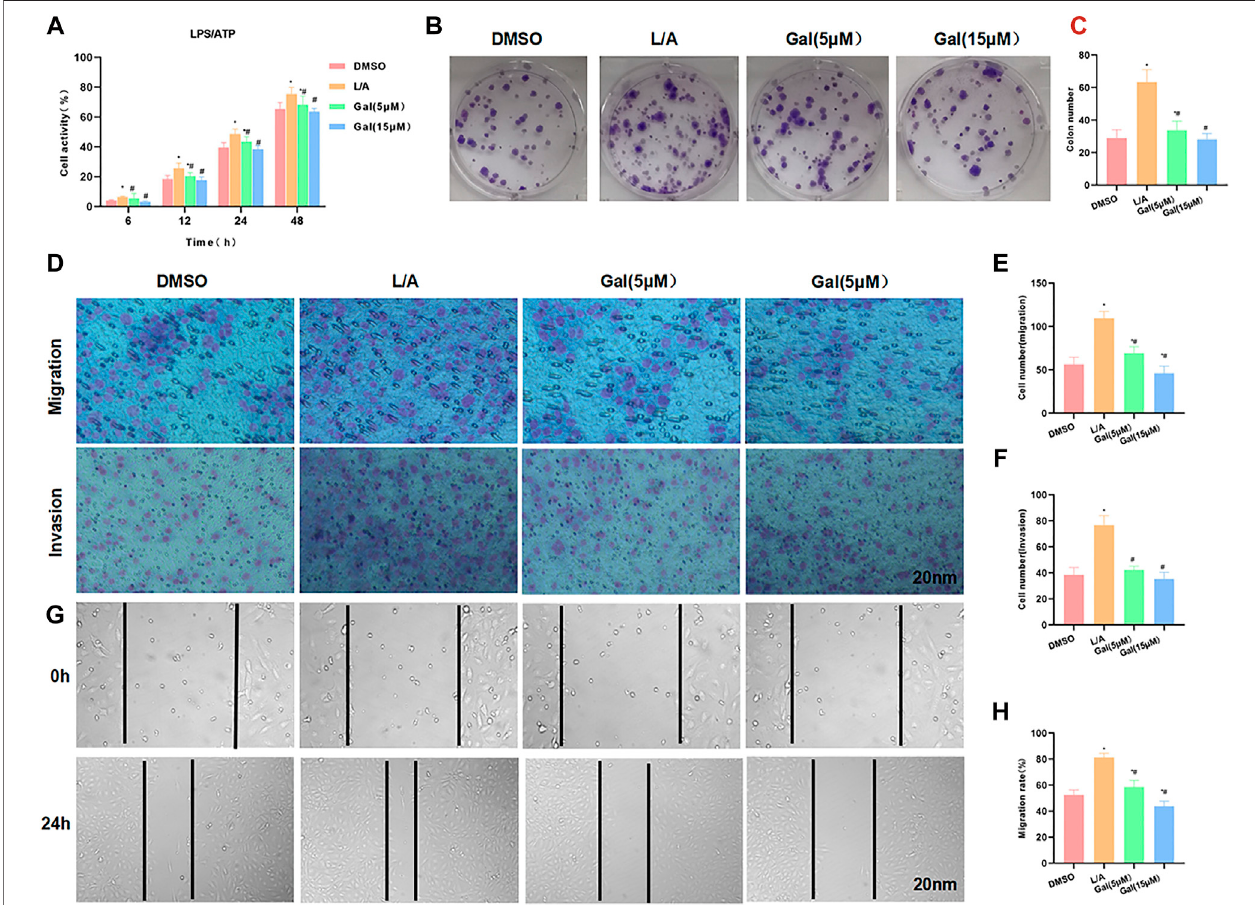
FIGURE 3 | Gallo fl avin inhibited the malignant behavior of SW480 in the in fl ammatory microenvironment. (A) : Cell viability assay revealed that Gal could inhibit cell proliferation in the in fl ammatory microenvironment, with a signi fi cantly decreased cell viability. High-dose Gal could better inhibit cell viability than that of low-dose. Comparison withthe DMSO group, * p < 0.05; Comparison with group A, # p < 0.05. (B,C) : Colony formationassay showed that Gal could inhibit thecolony formationof SW480, with a signi fi cantly lower number of colonies lower than L/A. Comparison with the DMSO group, * p < 0.05; comparison with the L/A group, # p <